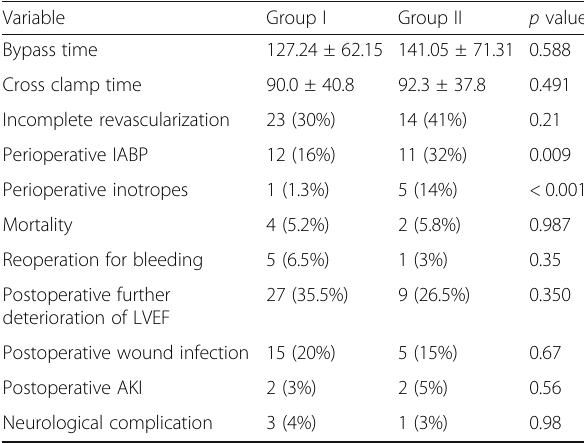
Table 3 Operative and postoperative outcome in the studied